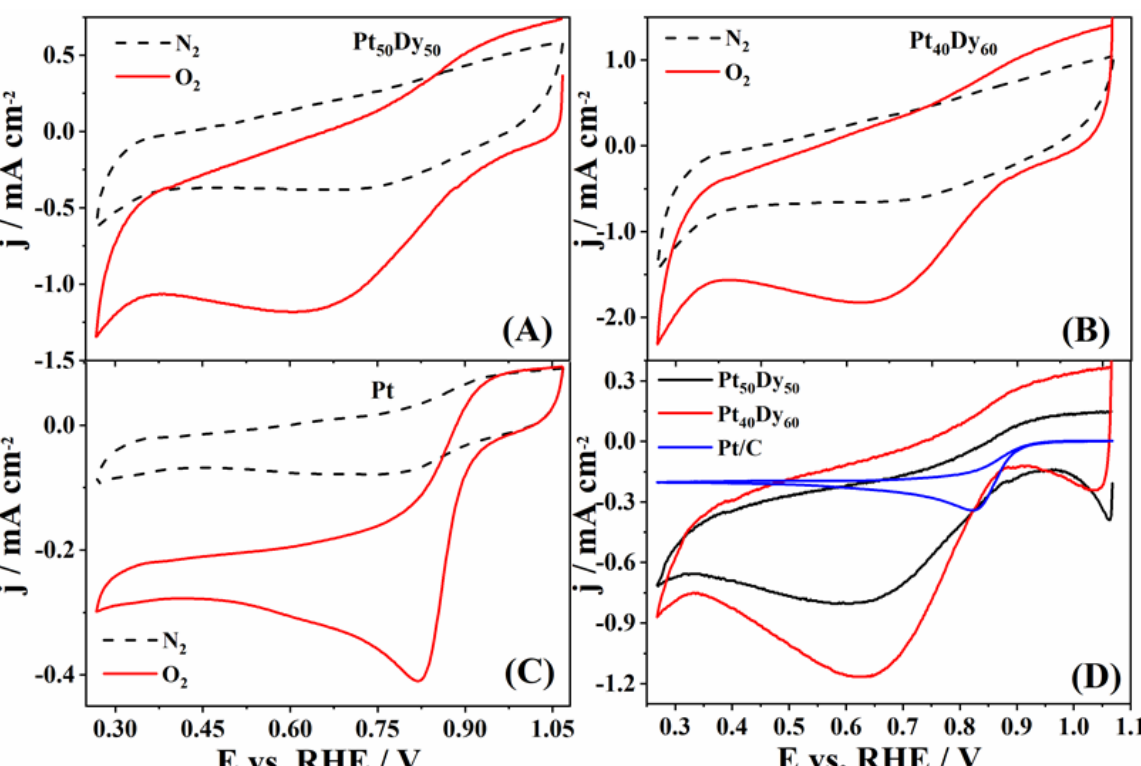
Figure 1. CVs of the Pt 50 Dy 50 ( A ), Pt 40 Dy 60 ( B ), and Pt ( C ) electrodes in N 2 - and O 2 -saturated 1 M NaOH and comparison of background current-corrected CVs of three electrodes ( D ) at a scan rate of 10 mV s −1 and 25 °C.